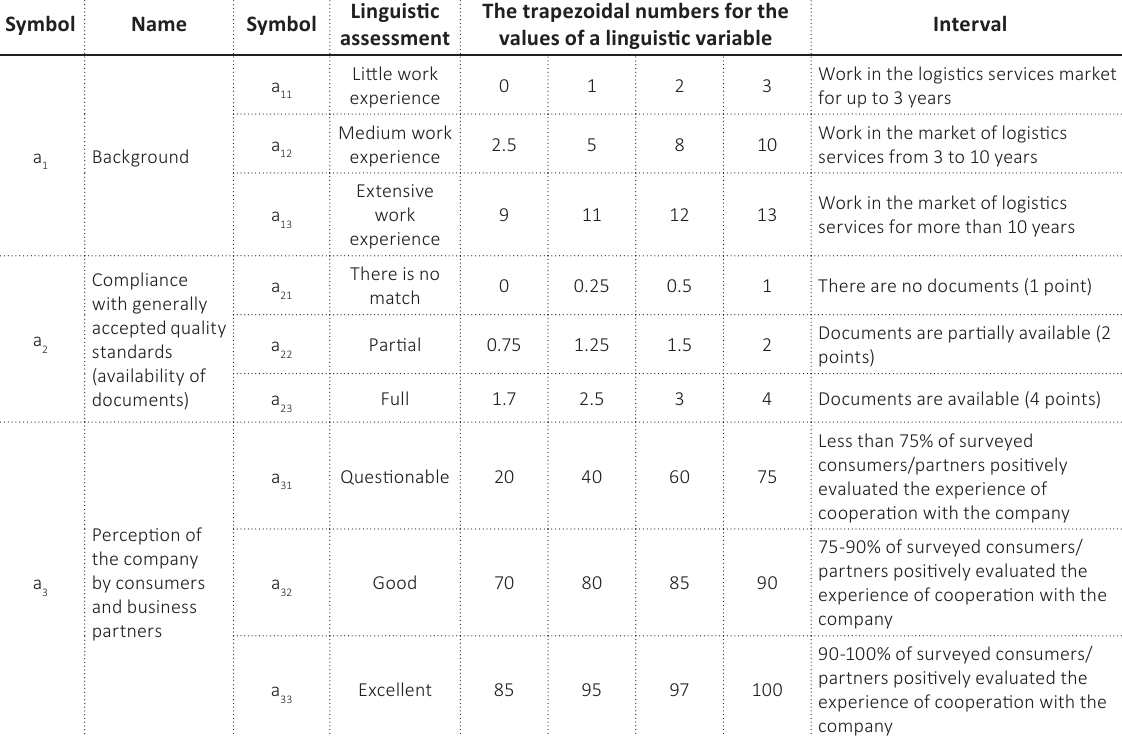
Table A1. Indicators for evaluating company reputation ( A )